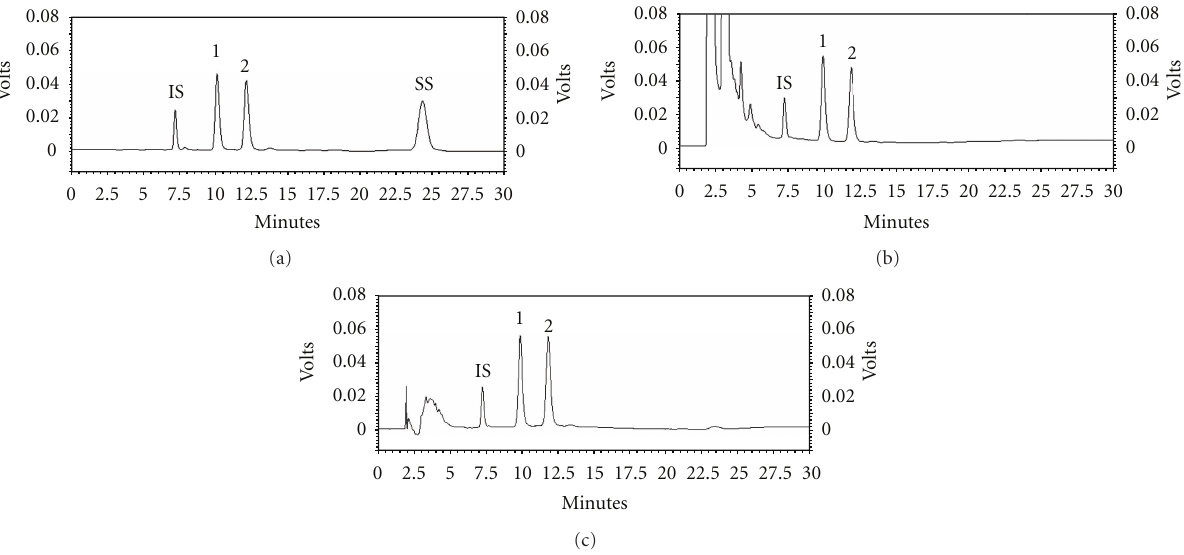
Figure 2: Chromatographic profiles by HPLC-UV: (a) standard compounds (b) hydroalcoholic extract of Solanum lycocarpum fruits (EtOH 80%) and (c) alkaloidic extract obtained from Solanum lycocarpum fruits. (IS) veratraldehyde, (1) solasonine, (2) solamargine, and (SS)